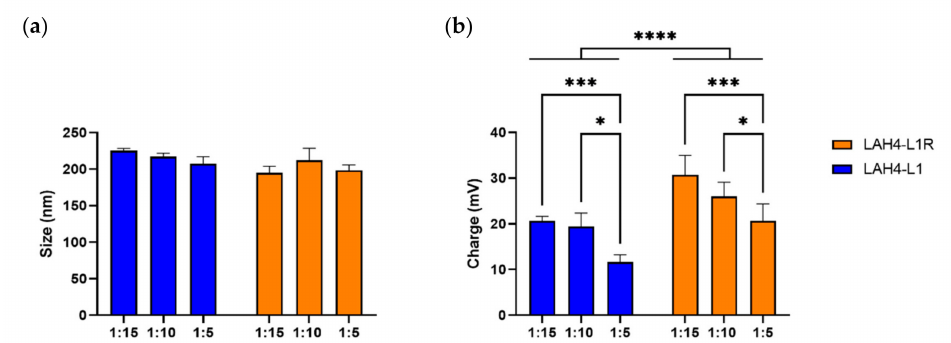
Figure 2. Characterization of histidine-rich peptide (HRP)–mRNA nanoparticles. Different ratios of mRNA:HRP ( µ g: µ g) were prepared for LAH4-L1 and LAH4-L1R. Size ( a ) and charge ( b ) were determined via ZetaView ® –NTA ( n = 3, mean ± SD). Two-way ANOVA, Tukey’s multiple comparison test: * p < 0.05, *** p < 0.001, **** p <